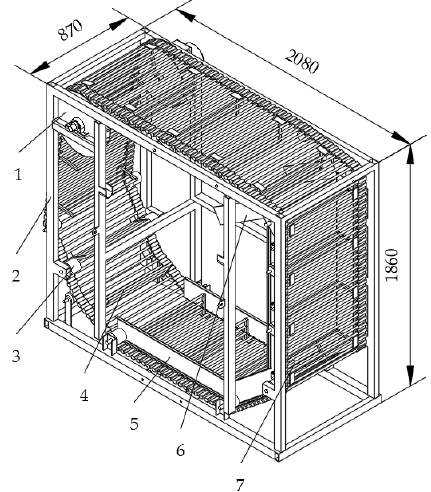
Figure 11. CAD model of the circulating and lifting device: 1—drive wheel; 2—bracket; 3—guide carrier pulley; 4—lifting scraper; 5—ba ffl e; 6—potato slide plate; 7—lifting screen.